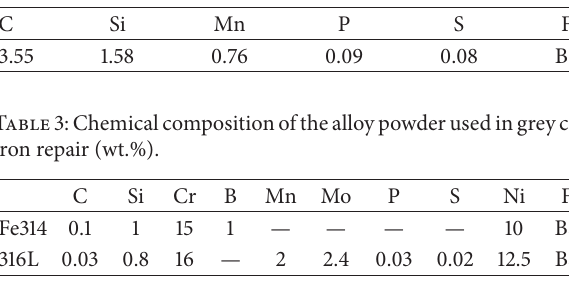
Figure 4: Metallographic structure of HAZ × 200: (a) Fe314 and (b)